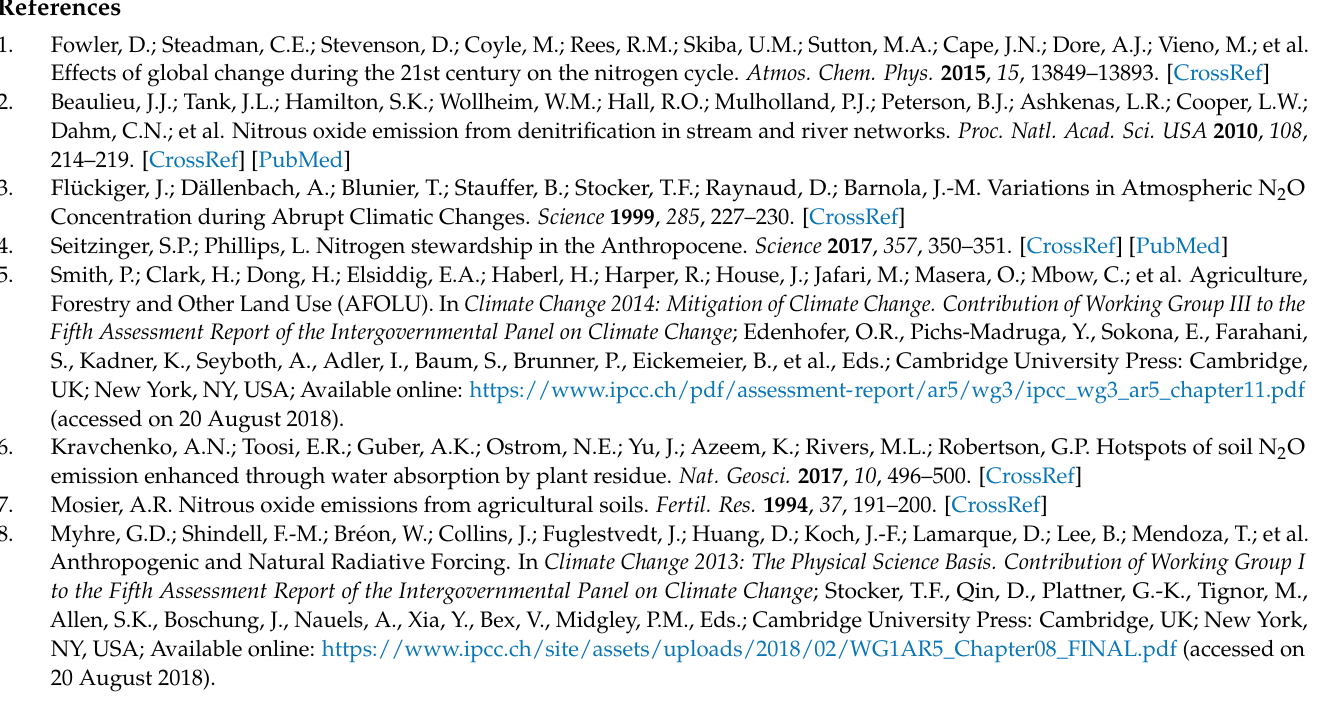
literature. Table S2. Soil texture parameters for nitrification rate. Table S3. Soil texture parameters for denitrification